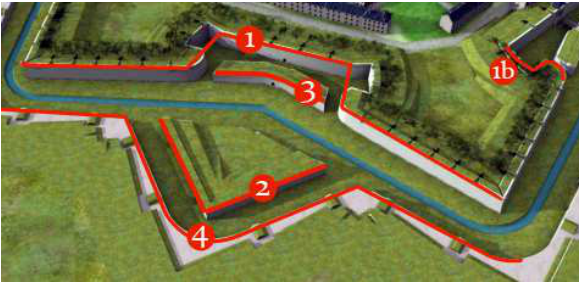
Figure 7 * . One bastioned front of the city wall (1), an orillon (1b), a demi-lune (2), a tenaille (3), a counterscarp (4) and their main lines in